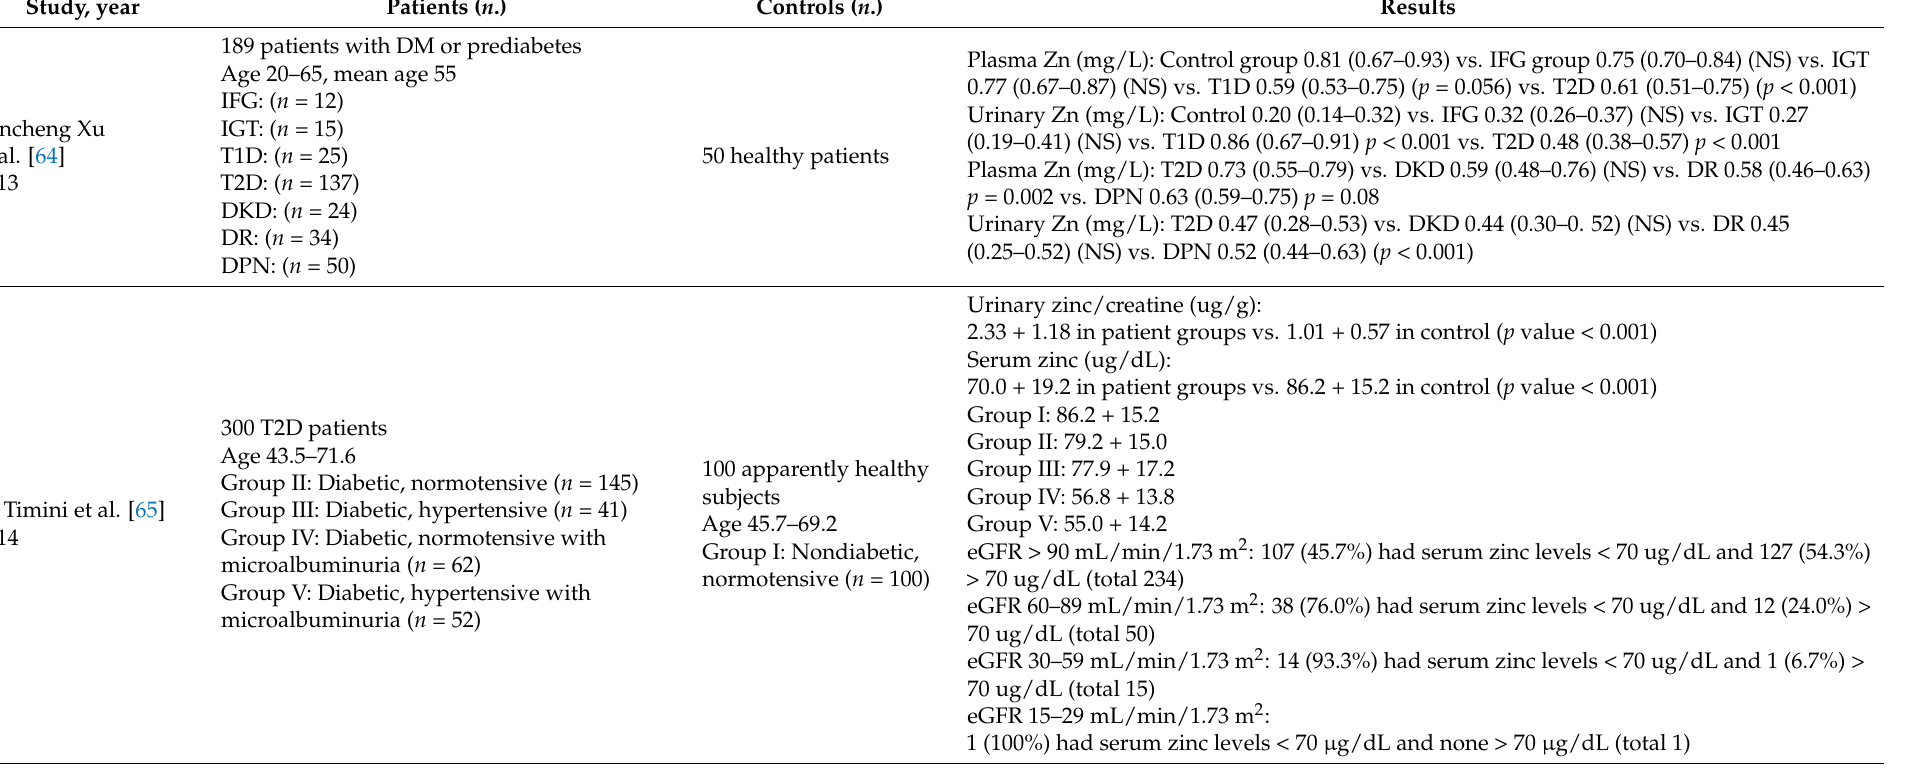
Patients ( n .) Controls ( n .)